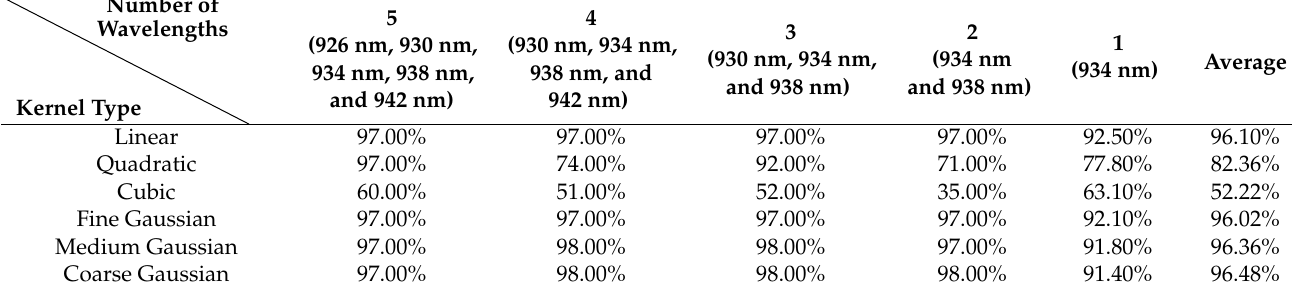
Table 6. Performance of each SVM model for AUC in each reduction of the number of wavelengths.